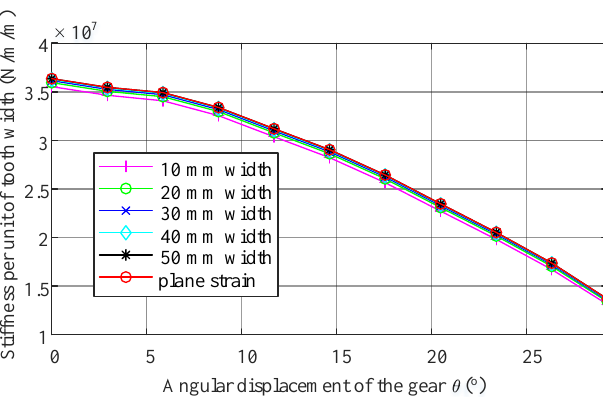
Figure 11. Comparison between 2-D and 3-D models. Table 6. Updated coe ffi cients for L , M , P and Q .